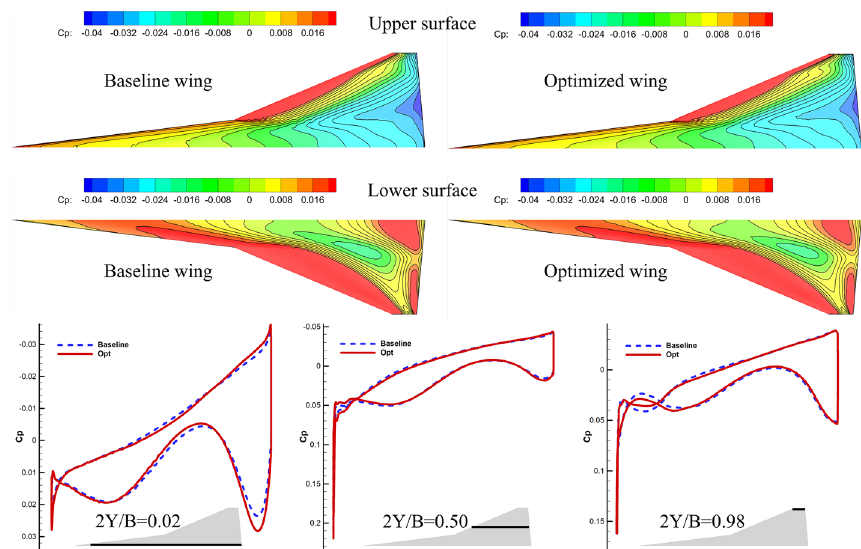
Fig. 30 Comparison of pressure coefficient contours and sectional pressure coefficient distributions at three wing spanwise locations for the baseline and optimized profiles (optimization case 2)